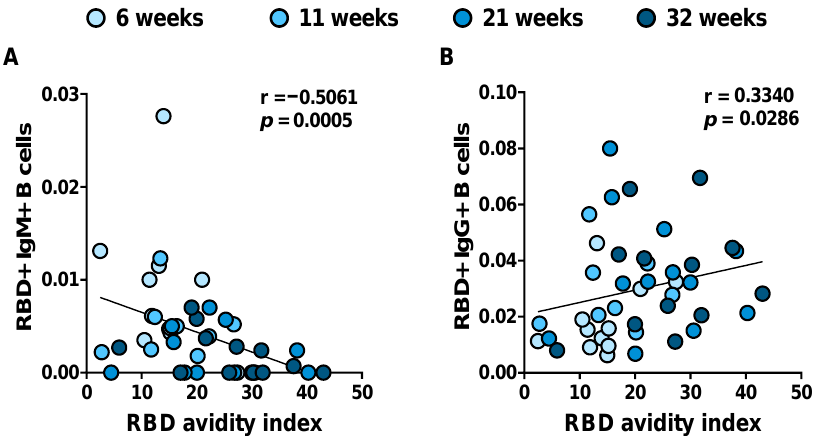
Figure 4. Correlations between RBD-specific B cells and RBD avidity index over time post-symptom onset . For 12 donors, characterization of RBD-specific B cells was monitored on longitudinal PBMC samples obtained from COVID-19+ convalescent individuals [8]. RBD avidity inversely correlates with RBD-specific IgM+ B cells ( A ) and correlates with RBD-specific IgG+ B cells ( B ). Statistical significance was tested using Spearman correlation tests.